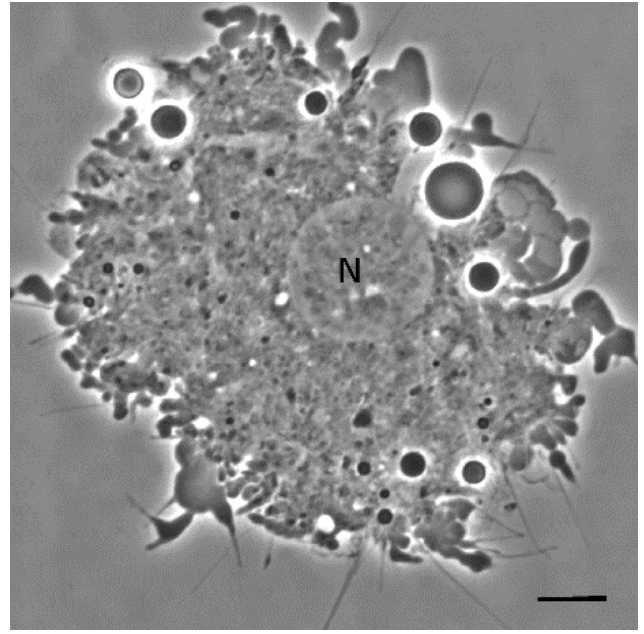
Figure 3. Phase contrast microscopy of a giant cell from fifth instar nymphs of Dipetalogaster maxima . N, nucleus. Bas: 10 μ m.